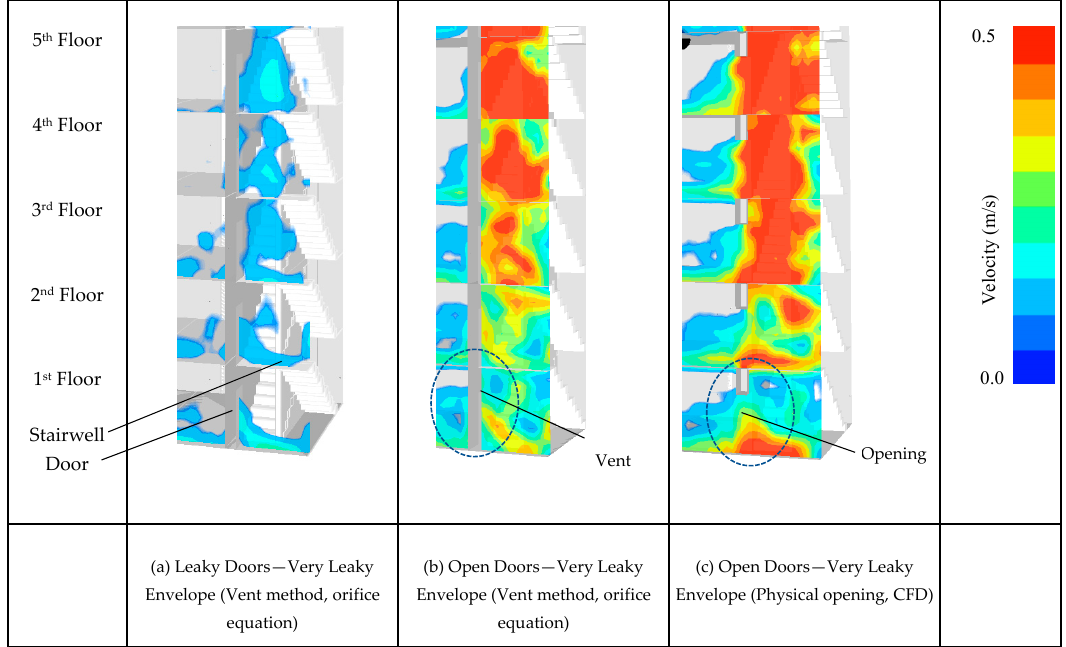
Figure 12. Airflow velocity along vertical plane for floors 1 to 5, for (a) leaky doors (b) open doors and